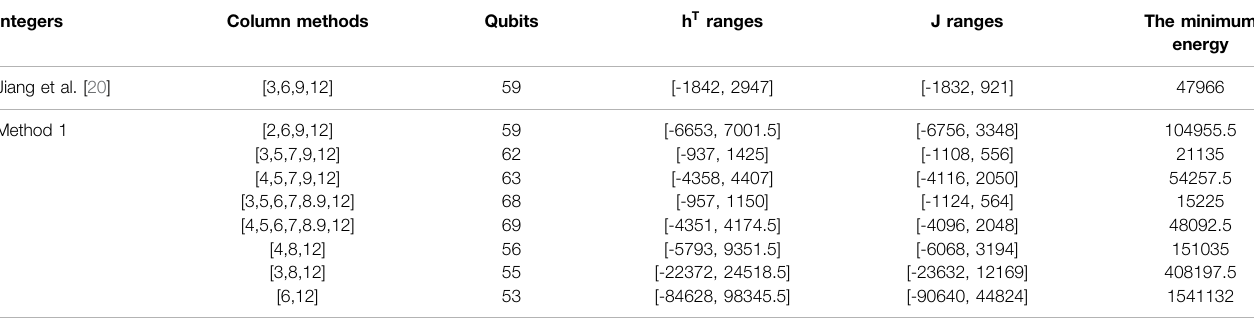
TABLE 3 | Different column methods for the integer 59989.